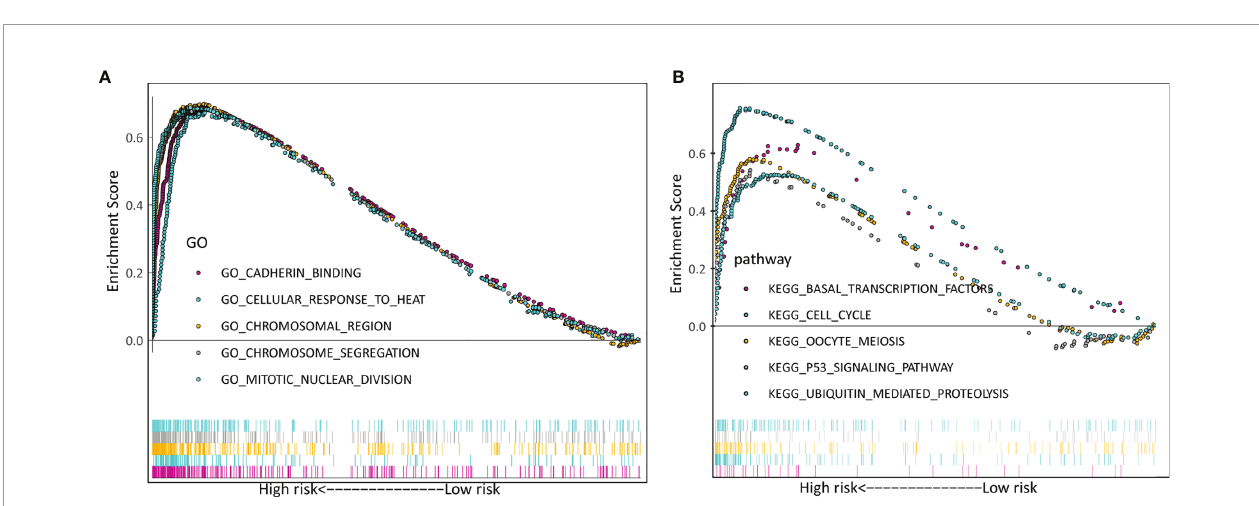
FIGURE 7 | Veri fi cation of the biosignature strati fi ed by different clinical parameters in the training set. (A) GO terms. (B) KEGG